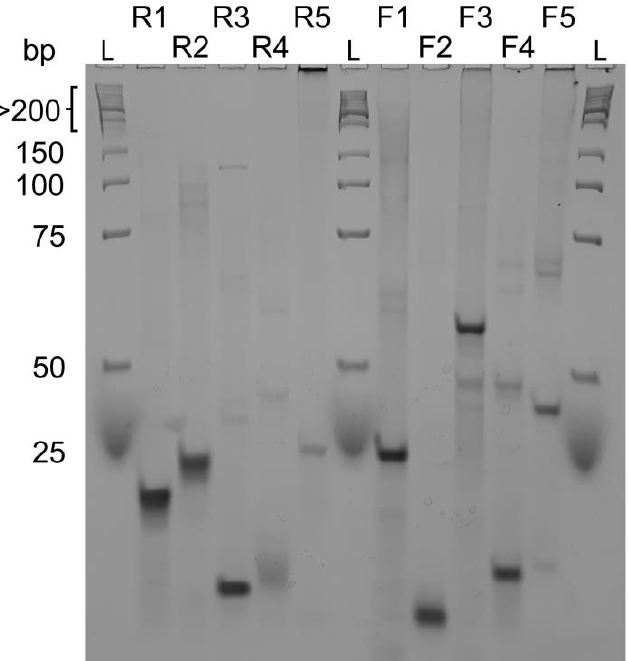
Figure 3. Native gel electrophoresis experiment of reverse sequences R1, R2, R3, R4, R5 and forward sequences F1, F2, F3, F4, F5 compared to a low molecular weight DNA ladder. R3, R4, F2 and F4 seem to form intramolecular G-quadruplexes whereas all other sequences form intermolecular structures. Native gel experiments were performed at 4 °C with 15% acrylamide/bisacrylamide (19:1 ratio) gels.